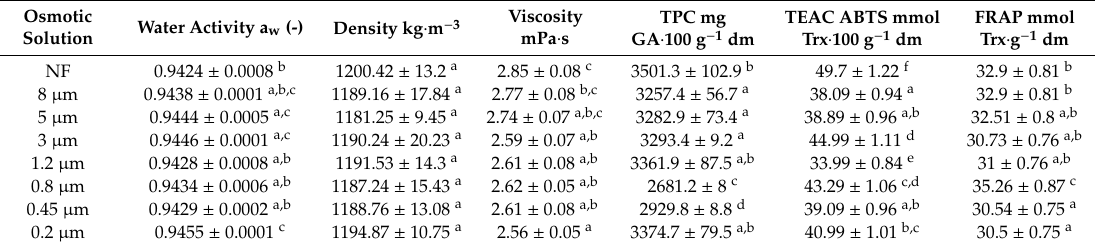
Table 1. Physical and chemical properties of fresh and filtered osmotic solutions before osmotic